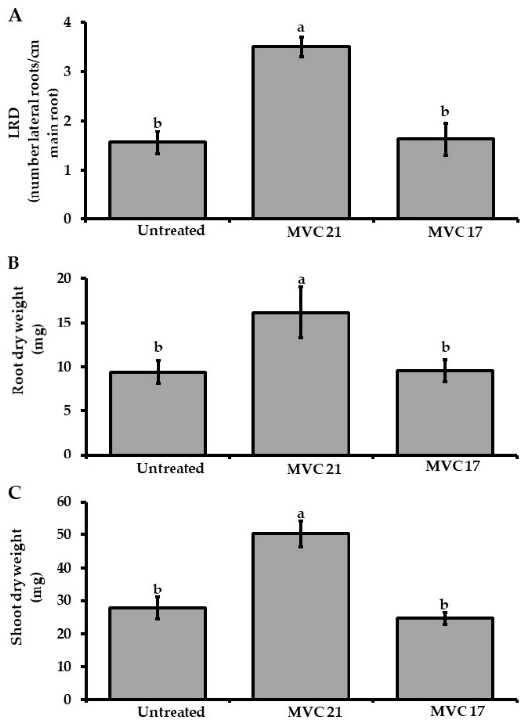
Figure 2. Plant growth-promoting effect of volatile organic compounds (VOCs) emitted by Pantoea agglomerans MVC 21 and Pseudomonas ( Ps .) putida MVC 17. Lateral Root Density (LRD) ( A ), root ( B ), and shoot ( C ) dry weight of tomato seedlings were assessed after 10 days of exposure to P. agglomerans MVC 21 and Ps. putida MVC17 VOCs. Untreated. tomato seedlings exposed to agar medium only; MVC 21. tomato seedlings exposed to P. agglomerans MVC 21 VOCs; MVC 17. tomato seedlings exposed to Ps. putida MVC17 VOCs. Columns represent mean ± standard error values of 12 replicates (tomato seedlings) are reported for each treatment. Data from two independent experiments were pooled. Different letters indicate significant differences among treatments according to Tukey´s test ( α = 0.05).